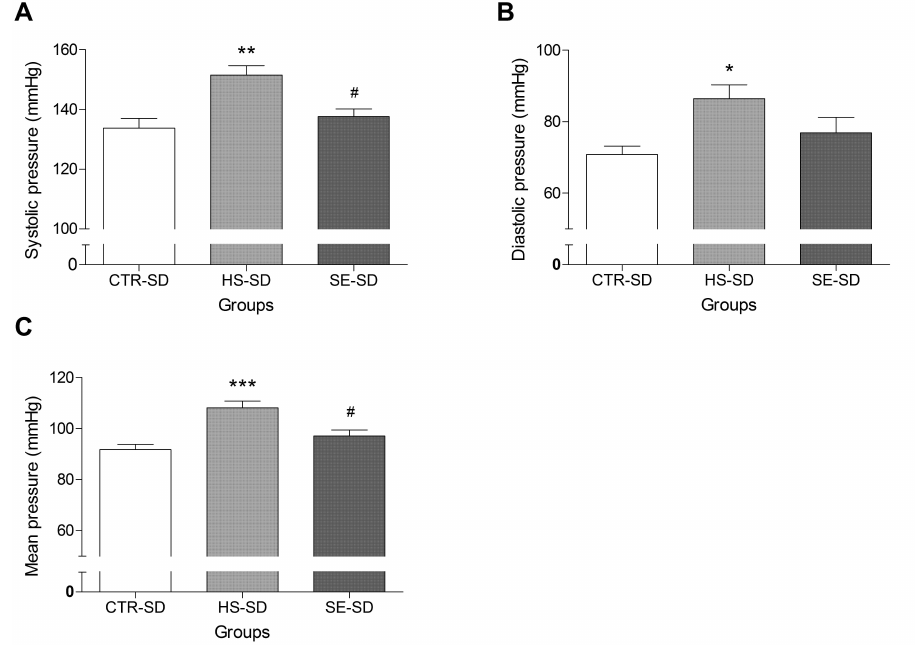
Figure 5. Effect of Salicornia europaea extracts (SE) on the systolic blood pressure ( A ); diastolic blood pressure ( B ); and mean arterial pressure ( C ) in a normotensive SD rat group (CTR–SD) compared with the values in a high edible salt-fed group (HS–SD, 800 mg/kg/day) and a group fed SE (SE–SD, 1400 mg/kg/day). Values are expressed as mean ˘ SEM. “*”, “**” and “***” stand for p < 0.05, p < 0.01, and p < 0.001 vs. CTR–SD, respectively. “#” stands for p < 0.05 vs.